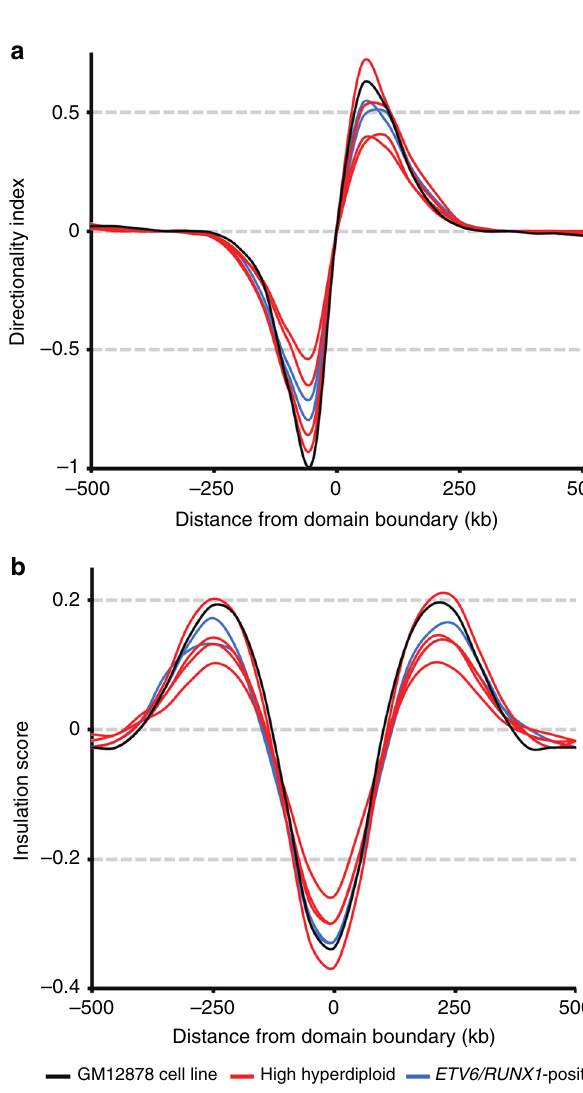
Fig. 6 Weaker topologically associating domain (TAD) boundaries in high hyperdiploid samples. a Median standardized directionality index pro fi les around TAD boundaries identi fi ed in high hyperdiploid cases (red), ETV6/ RUNX1 -positive cases (blue) and the GM12878 cell line (black). Two high hyperdiploid cases (HeH_9 and HeH_10) showed markedly decreased boundary strength, indicating permissive TAD boundaries. b